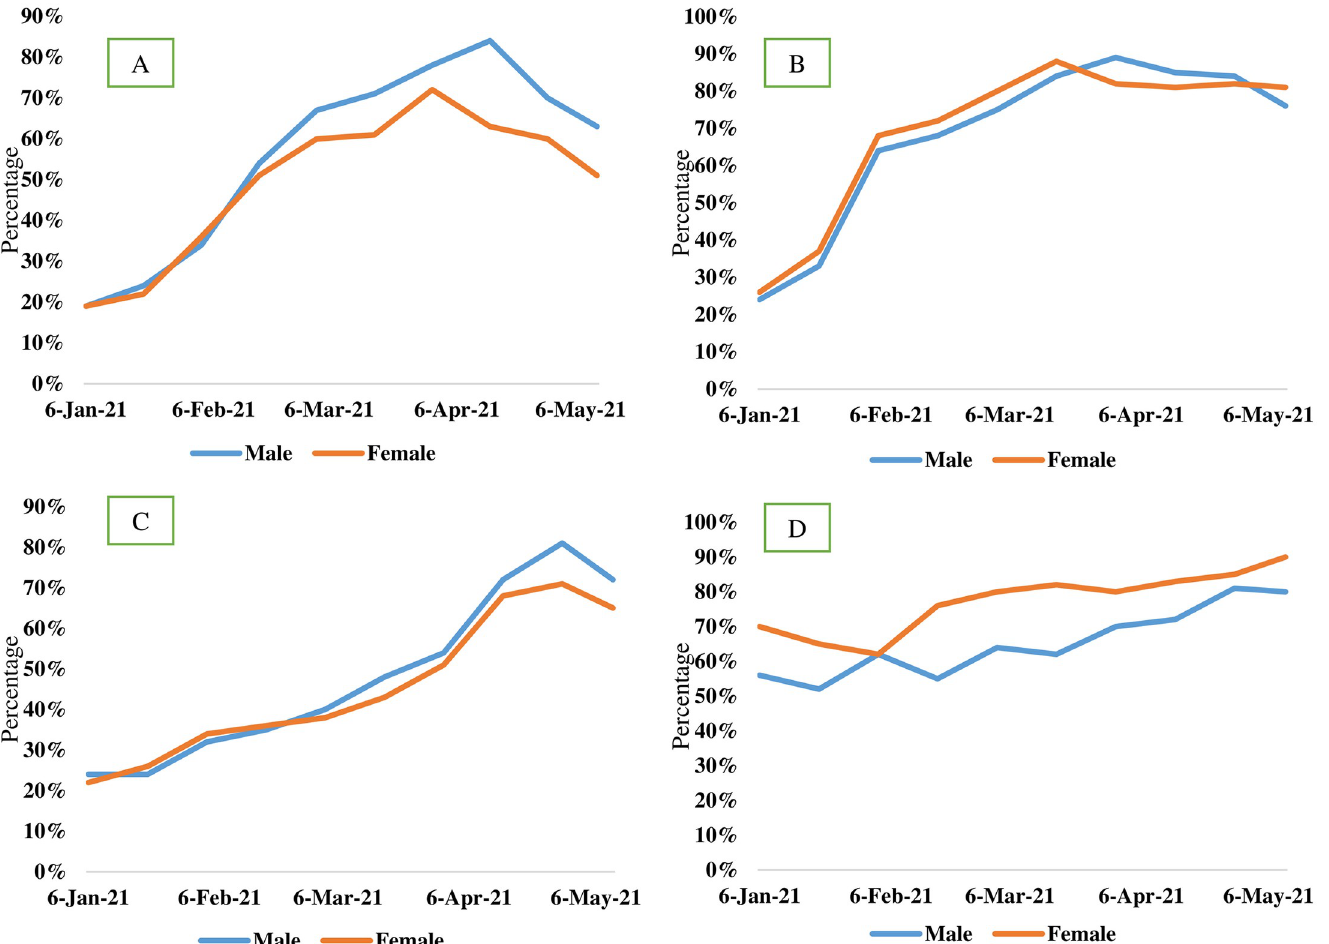
Fig 4. Gender-wise changes of the frequency of A. Using face masks, B. Cleaning hands, C. Maintaining social distance and D. Avoiding hand shaking among the participants with the progress of the second wave.